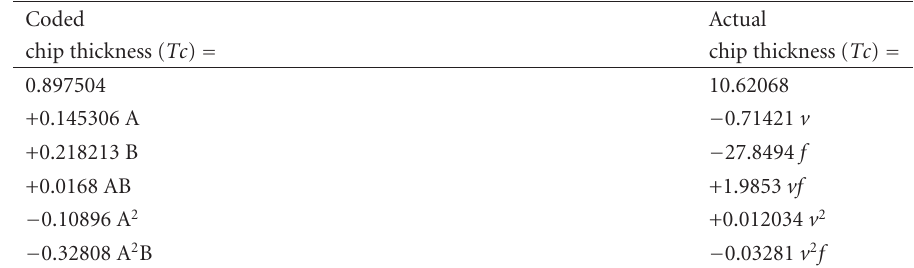
Table 6 . 2 . Final equation for chip thickness in terms of coded and actual